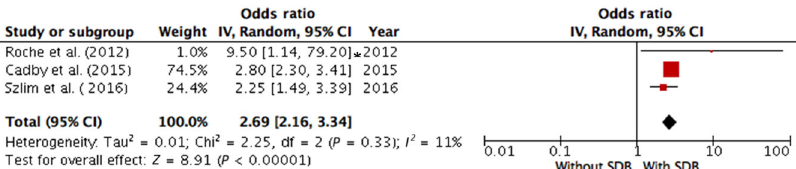
Fig. 5 Meta-analysis of association between sleep-disordered breathing and risk of cardiovascular disease (odds ratios) in a population at high risk of SDB. Roche et al. (2002) AHI cut-off 10, outcome — nocturnal paroxysmal asystole ; Cadby et al. (2015) AHI cut-off 5, outcome — atrial fi brillation; Szlim et al. (2016) AHI cut-off 15, outcome — nocturnal cardiac arrhythmias. AHI apnea-hypopnea index, CI con fi dence interval, IV inversed variance, SDB sleep-disordered breathing. *-calculated